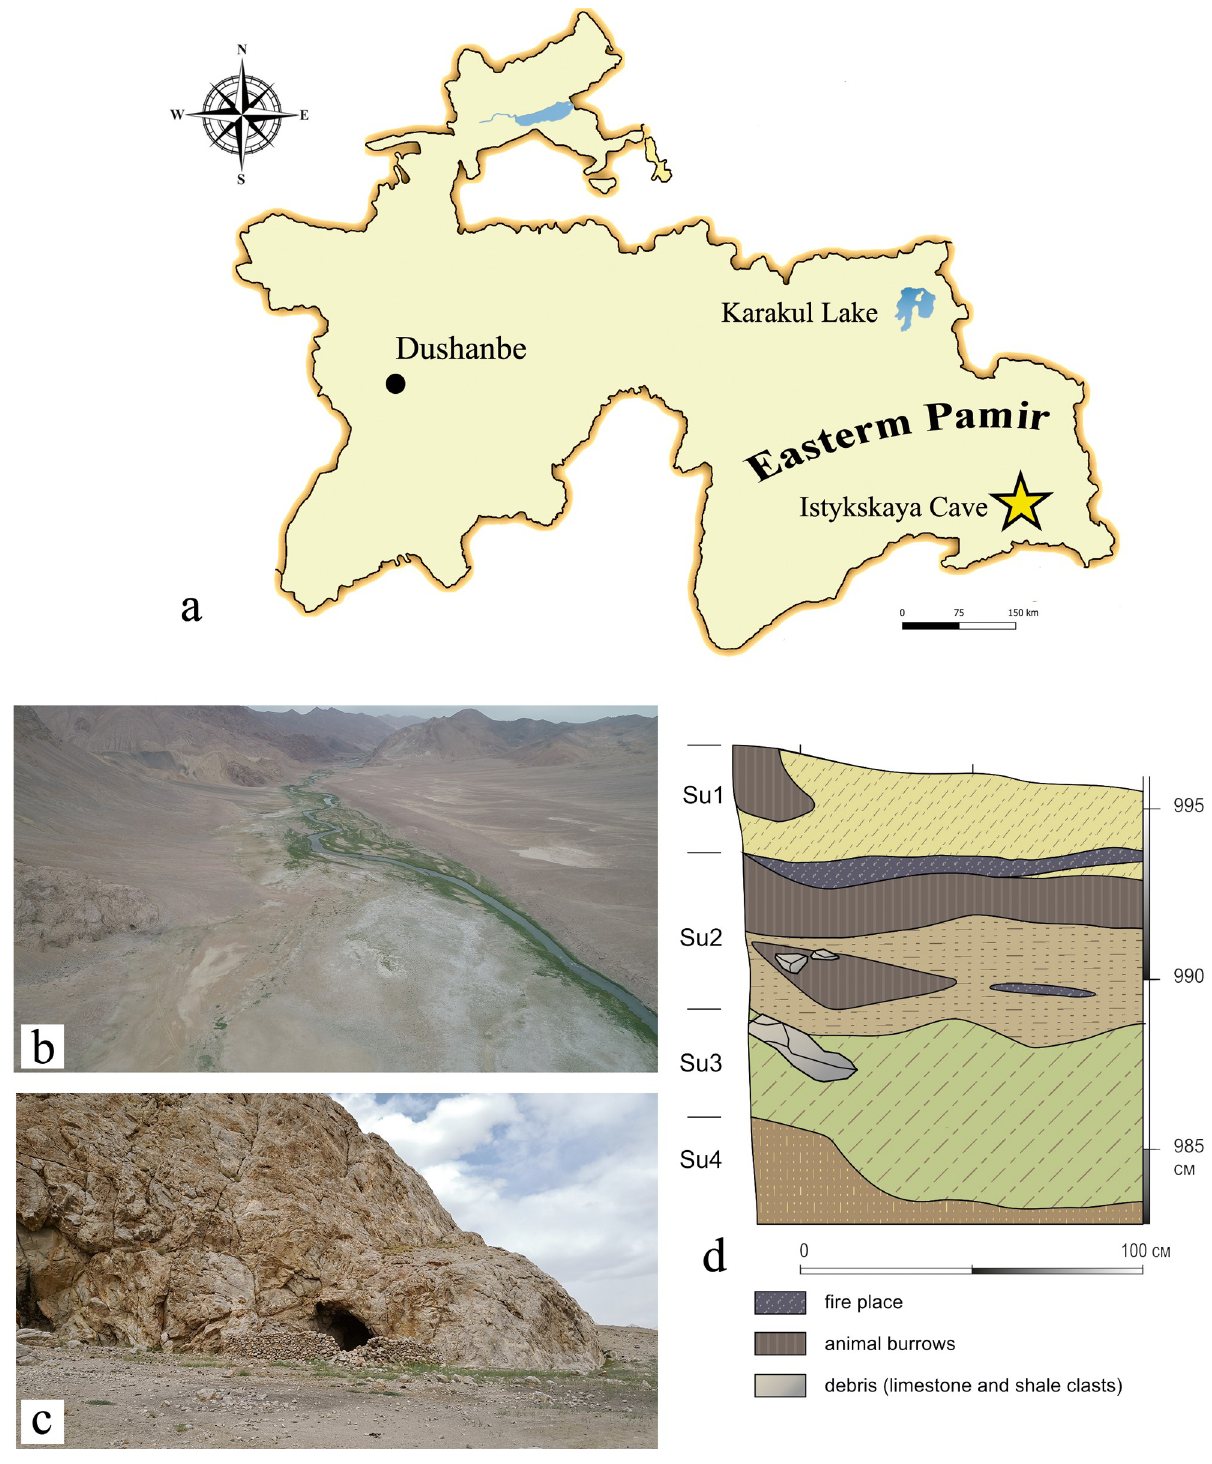
Fig 1. Istykskaya cave. (a) Site location (star) in the Pamir region. (b) View of the valley of Sul-Iistyk river. (c) View of the cave entrance. (d) Stratigraphic NE profiles of the cave as of 2019.